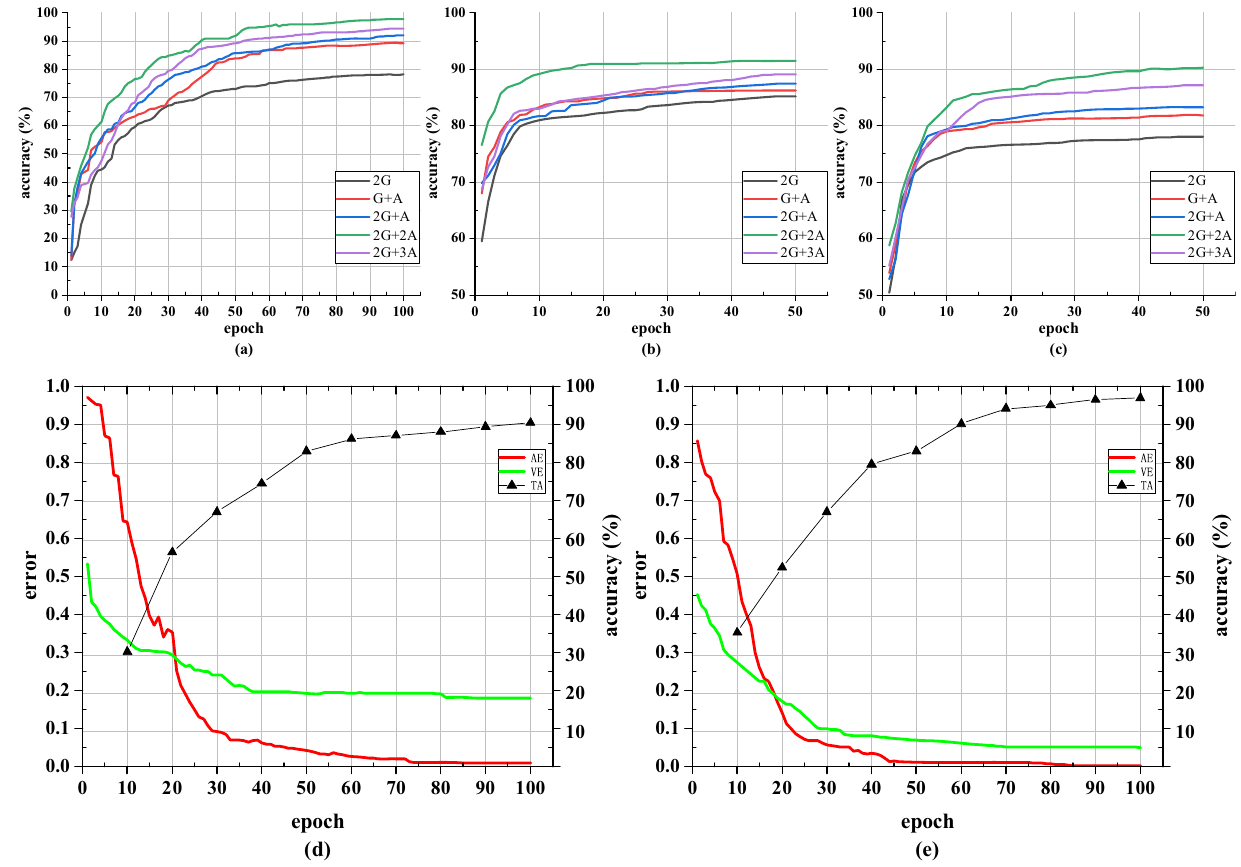
Fig. 8 Metric (VA, TE, VE and TA) changes when training the pro- posed GRAN model: a training of models with different layers on data-augmented PDC, b training of models with different layers on